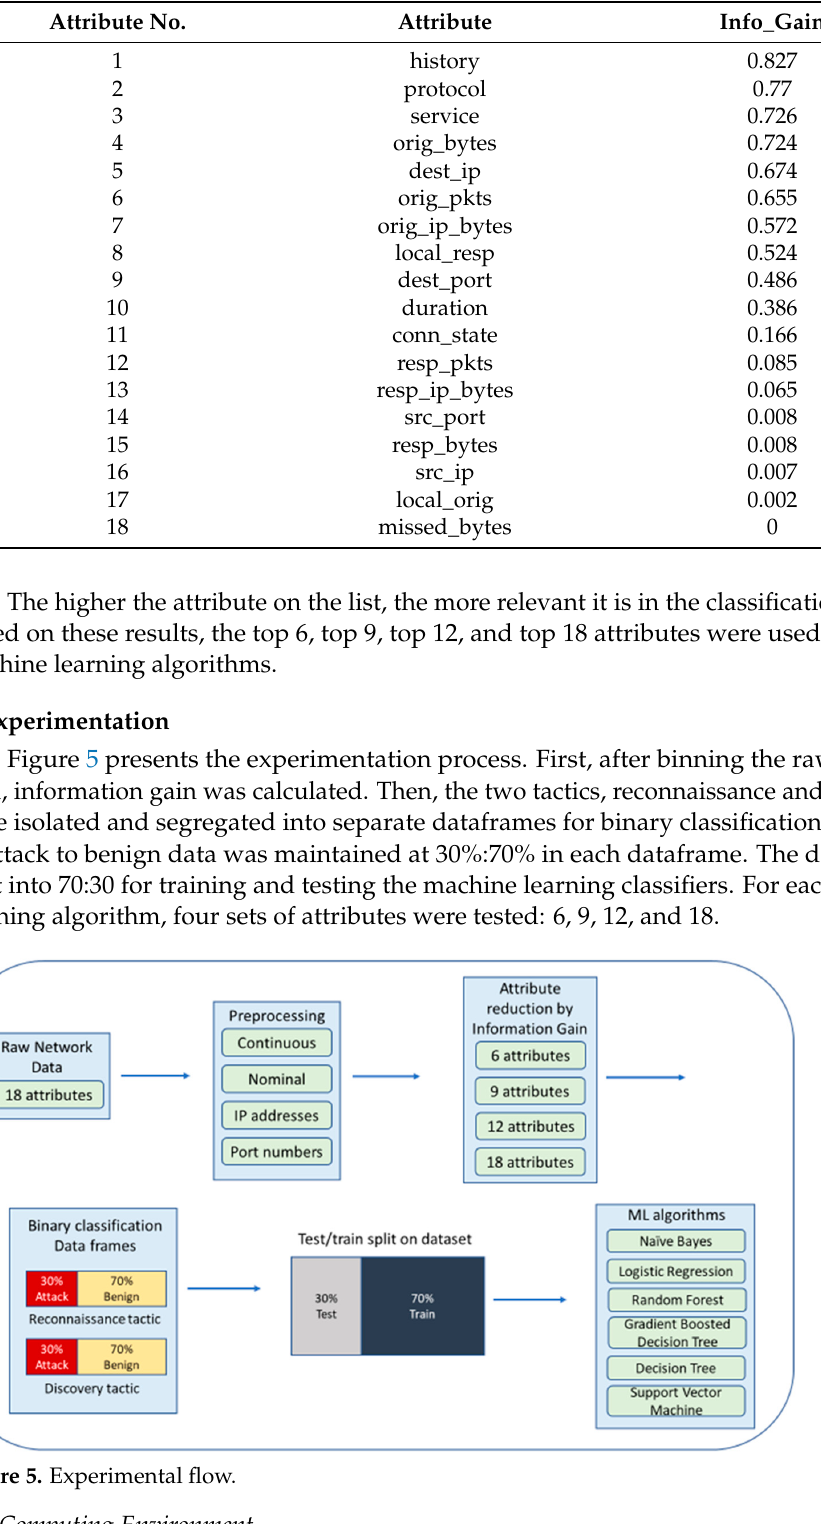
Table 12. Information gain for features in Zeek Conn dataset.